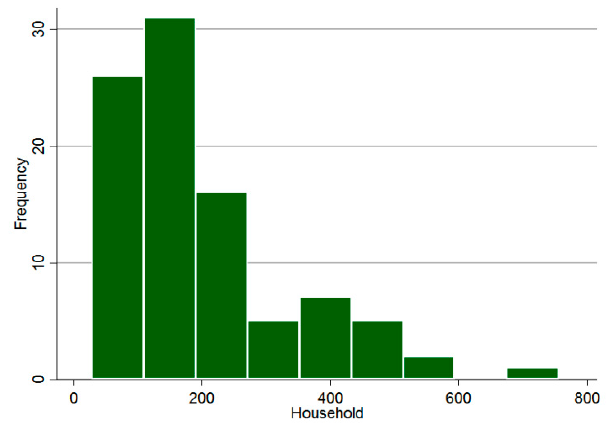
Figure 3. Sample size of household data in reviewed case studies. Note: For the graph one study with a sample size of 3554 households has been excluded.